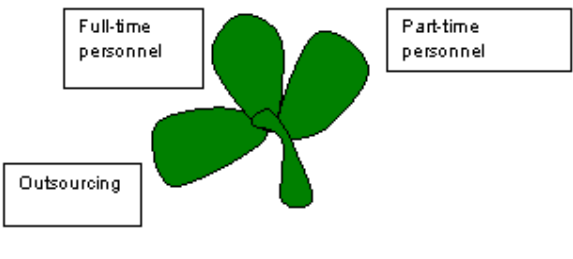
. Figure 1. UOC’s HR organisational